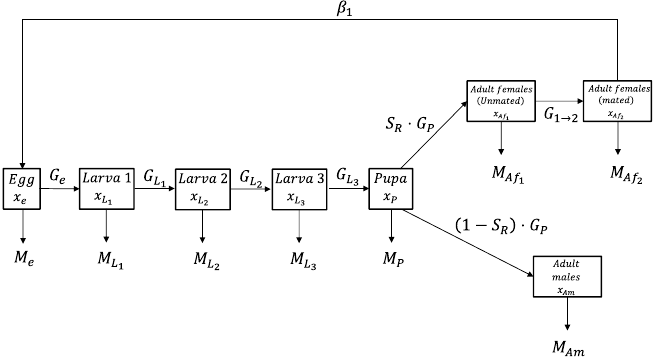
Figure 1. Schematic representation of the model (3), describing the Bactrocera oleae life cycle.